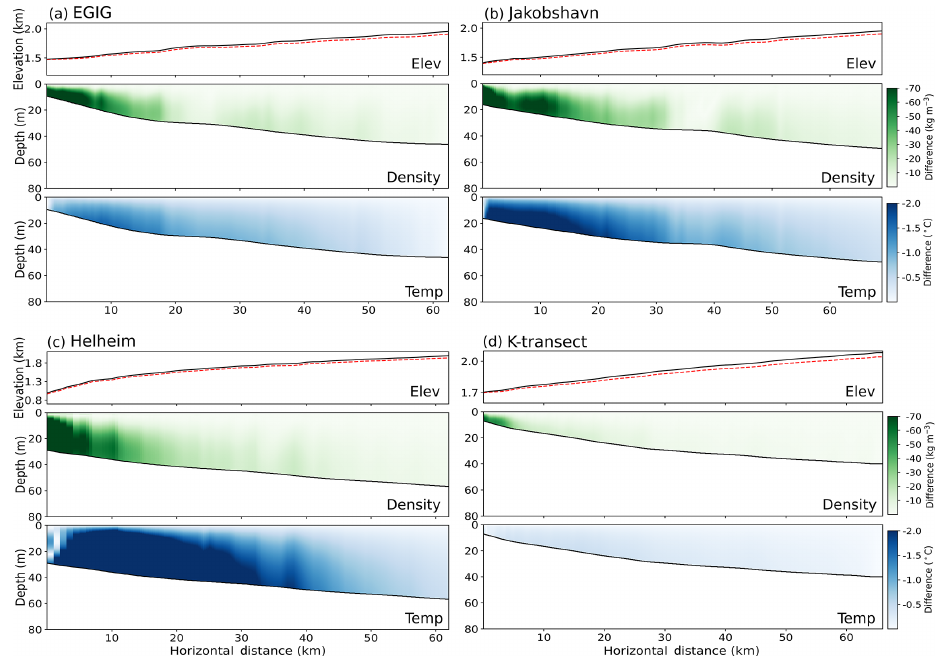
Figure 3. Calculated difference between 2D- and 1D-simulated firn properties in the percolation zone through the four study transects with the bucket method meltwater infiltration scheme: (a) EGIG line, (b) Jakobshavn, (c) Helheim, and (d) K-transect. The top panel in each transect shows surface topography (black) and pore close-off depth (red dashed). The middle panel shows density differences (2D − 1D), and the bottom panel shows temperature differences. Different transect lengths reflect different percolation zone extents based on the definition stated in the text.